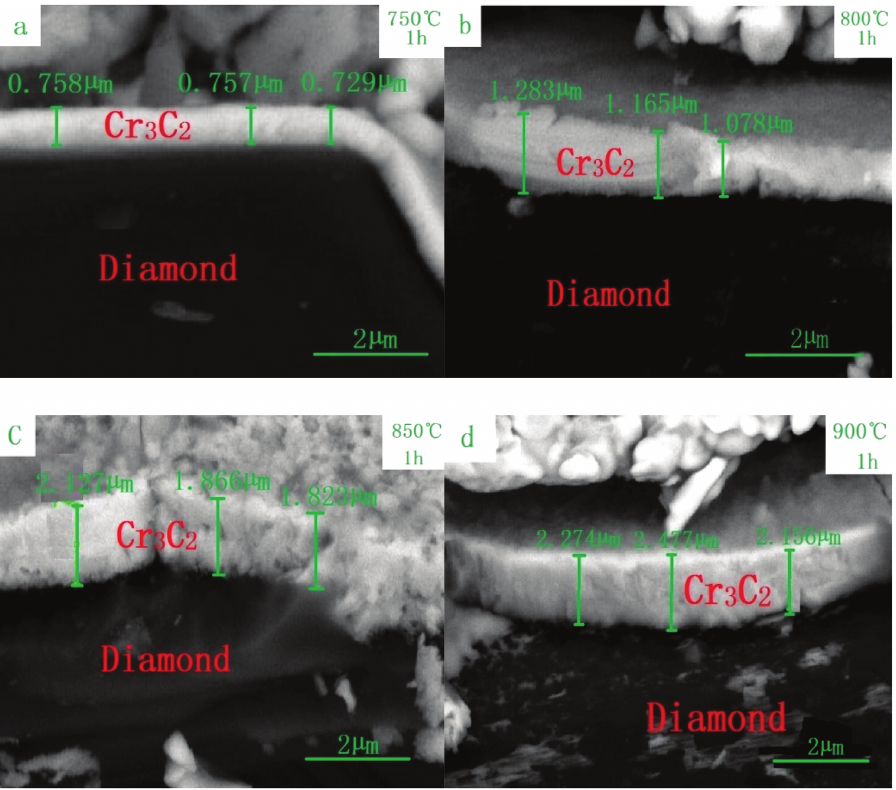
Figure 8: The coating thickness of SEM images by microwave heating at different temperatures for 1